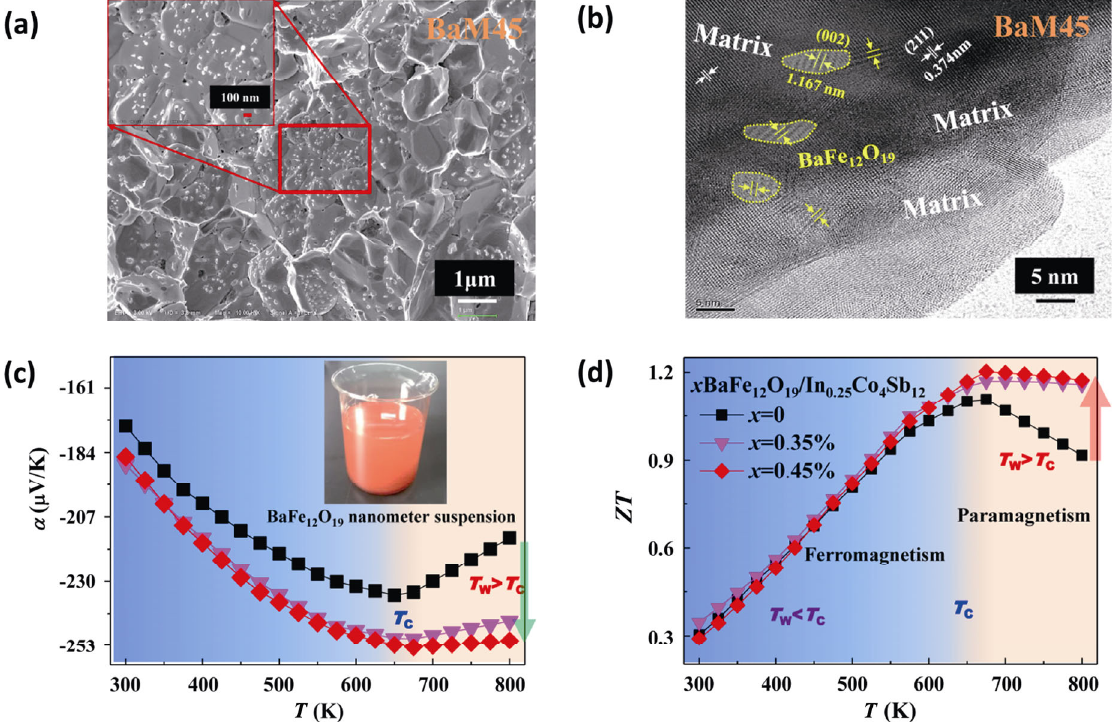
Fig. 12 (a) FESEM image of 0.45%BaFe 12 O 19 /In 0.25 Co 4 Sb 12 (BaM45) bulk material produced by an ultrasonic mixing of BaFe 12 O 19 nanometer suspension and In 0.25 Co 4 Sb 12 matrix material combined with spark plasma sintering; (b) HRTEM image of BaM45 bulk material; temperature dependences of (c) Seebeck coefficient and (d) ZT values of In 0.25 Co 4 Sb 12 matrix and BaFe 12 O 19 /In 0.25 Co 4 Sb 12 nanocomposites; T W is the work temperature, T C is the Curie temperature. Reproduced with permission from Ref. [195], © American Chemical Society